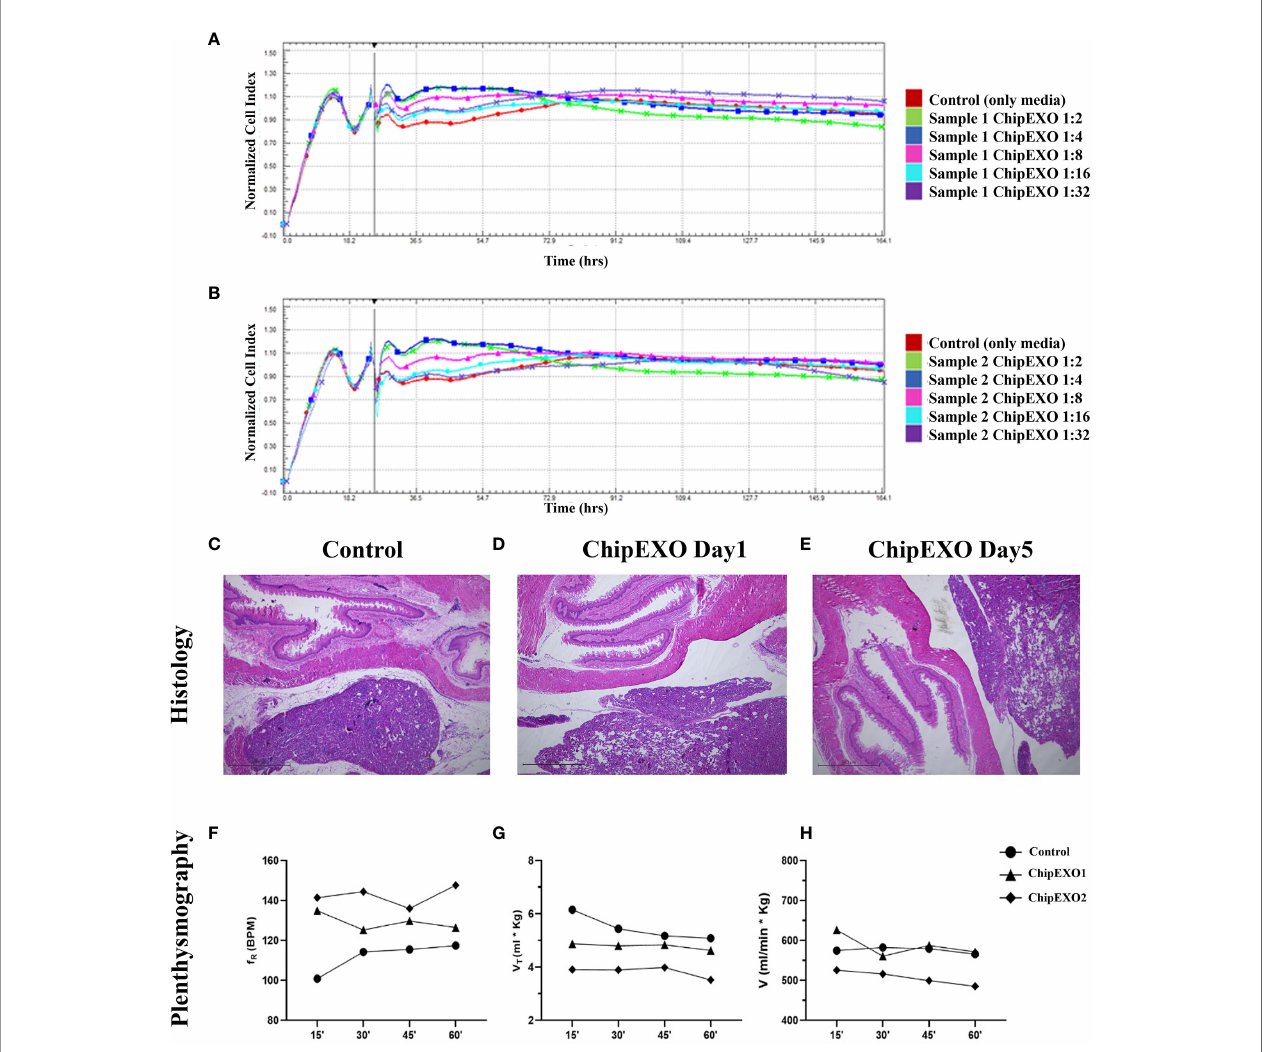
FIGURE 5 | Cytotoxicity of ChipEXOs from donor samples — sample 1 (A) and sample 2 (B) — on Vero E6 cells by real-time cytotoxicity assay on RTCA MP real-time cell analysis system. The data in the fi gure have been adjusted to the time point when the virus was added to the experiment. Histology: (C) control and (D) day 1 and (E) day 5 — the exosome-administered animal showed no pathological changes in lung tissue of hematoxylin – eosin (H&E)-stained sections; ×4 magni fi cation. Plethysmography: time activity for intratracheal instillation ChipEXOs. Exposure to normoxia (21.0% O 2 ) groups does not affect respiratory frequency (fR) (F) . Tidal volume (Vt) (G) and minute ventilation (V) (H) during whole-body plethysmography measurement. Bonferroni after repeated measures two-way ANOVA; all data presented as mean ± SEM: N = 1 for the control group and N = 2 for the exosome group. (The x -axis shows time in minutes). The difference for the plethysmography data points between the treated and untreated control was not statistically signi fi